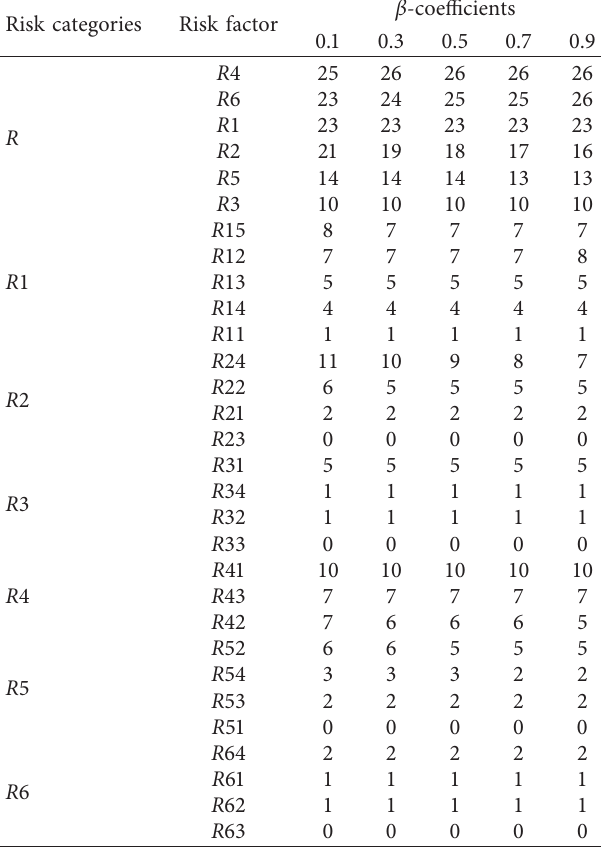
Table 12: The posterior probability of risk factors according to β